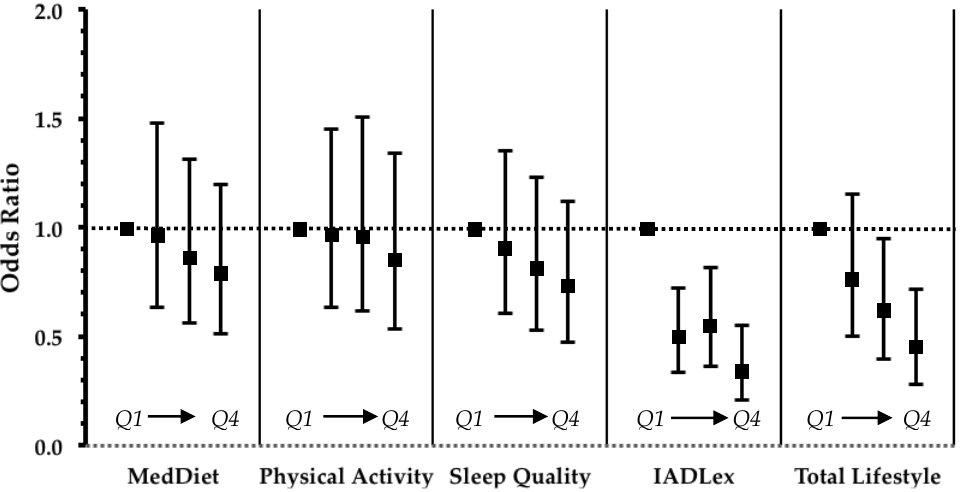
Figure 1. Results from logistic regression that evaluated the impact of lifestyle factors and TLI on the odds ratio of MCI in non-demented participants. Values are odds ratios with error bars representing 95% confidence intervals. In all models age, sex and education were entered as confounders. Statistically significant linear trends at p < 0.05 were observed for IADLex and Total Lifestyle. MedDiet: Mediterranean diet, IADLex: instrumental activities of daily living extended scale. Q: quartile ( Q1 lowest, Q4